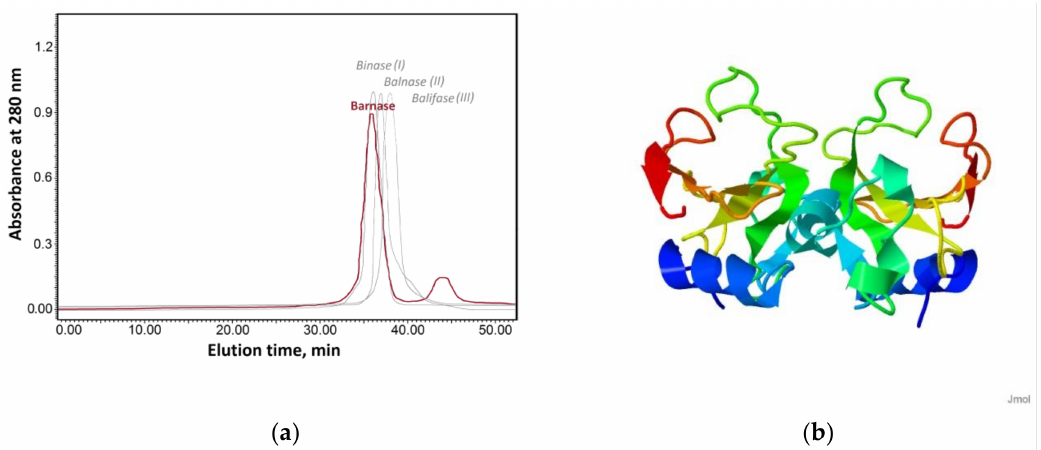
Figure 6. The structural organization of barnase. ( a ) Size exclusion chromatography of barnase in comparison to binase (I), balnase (II) and balifase (III). Major peaks correspond to dimer form of RNases, minor peak is represented by barnase monomer. Molecular weights of barnase peaks were calculated using equation obtained from elution profile of marker proteins. ( b ) Putative model of barnase